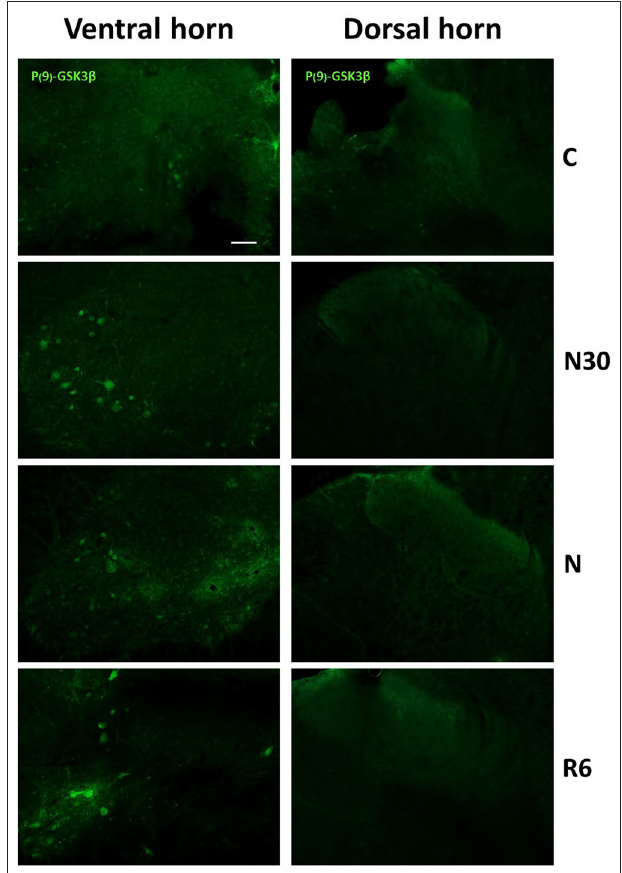
FIGURE 5 | Representative pictures showing the staining for P(9)-GSK3 β (inactive form, secondary conjugated with Alexa-488) are shown for the ventral (left) and dorsal (right) horns of the spinal cord. C, control; N30, samples taken during the induction of synthetic torpor (ST), when brain temperature (Tb) reached 30 ◦ C; N, samples taken at nadir of hypothermia, during the ST bout; R6, samples taken 6h after Tb reached 35.5 ◦ C following ST. Calibration bar: 100 µ m.